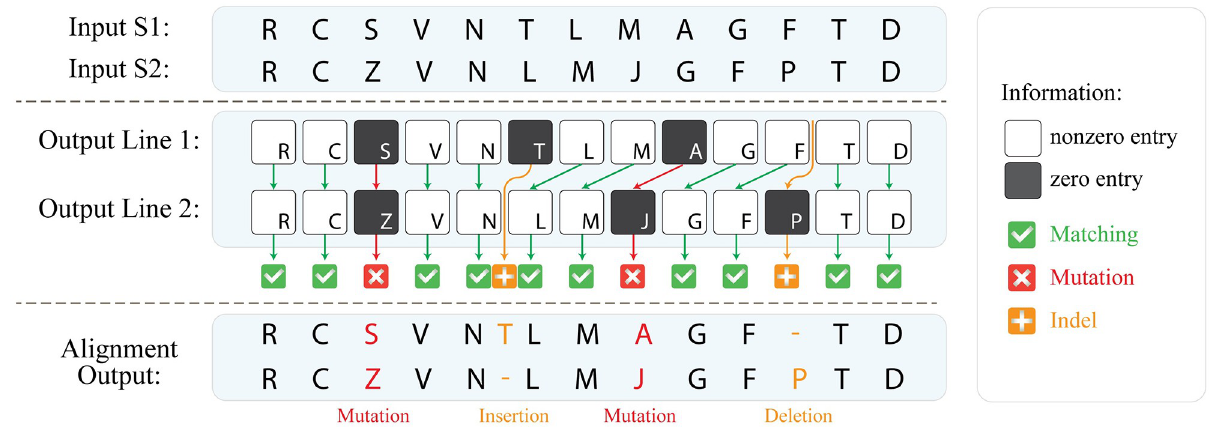
Fig 5. Output explanation of the HELIOS method. The output of the HELIOS method is represented with a two-row matrix, while the first and second rows are produced by the S 1 -align and S 2 -align operations, respectively. Moreover, each entry represents the alignment output of the characters at the corresponding position in the input sequences. By traversing the output from left to right, nonzero entries in both rows depict identical characters, i.e. character matching; while zero entries in both rows depict character mutation. Finally, a zero entry of a row along with a nonzero entry of the other one indicates indel, i.e. character insertion or deletion, and can be represented by a gap at the corresponding position of the sequence, containing the nonzero